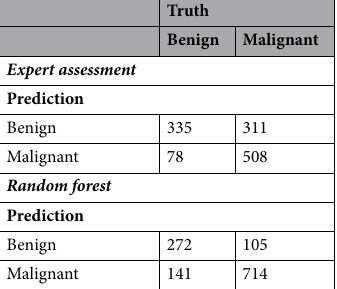
Table 5. The confusion matrices of expert assessment and random forest. The expert assessment is the majority vote of three surgeons’ judgments. The diagonal elements are the correct predictions. The off-diagonal elements are the wrong